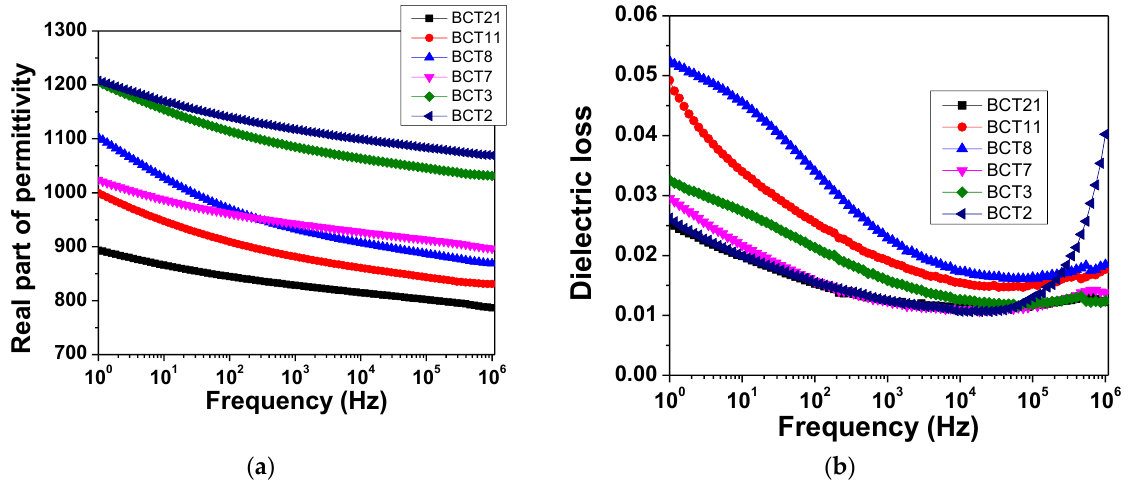
Figure 3. Frequency dependence of the real part of permittivity ( a ) and dielectric loss ( b ) at room temperature for Ba 0.90 Ca 0.10 TiO 3 ceramics with different porosity levels.